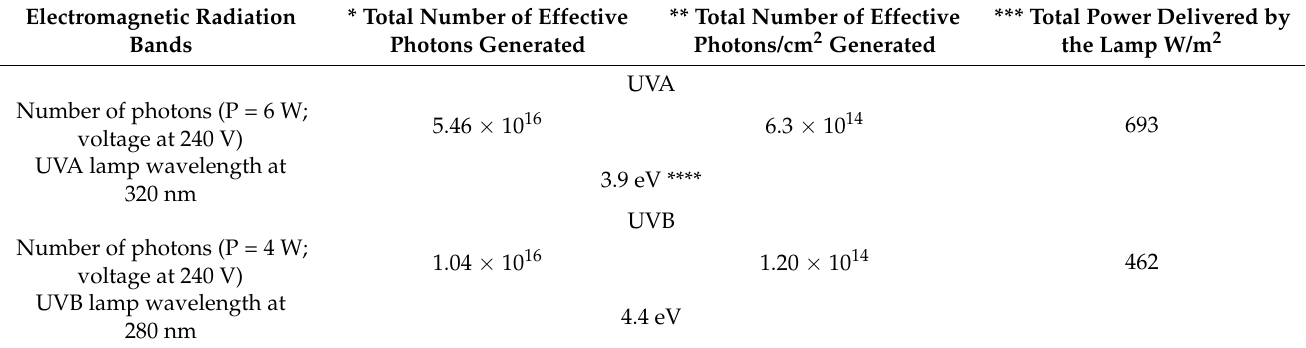
Table 2. A summarised list of the fluence (photons/cm 2 ) on the surface of water within the beaker containing a single fish (fluence is number of photons impinging on the surface of water). We also calculated the power of both the UVA (693 W/m 2 ) and UVB (462 W/m 2 ), respectively, and then compared them with that of solar power delivered (1413 W/m 2 ) on the surface of the Earth.